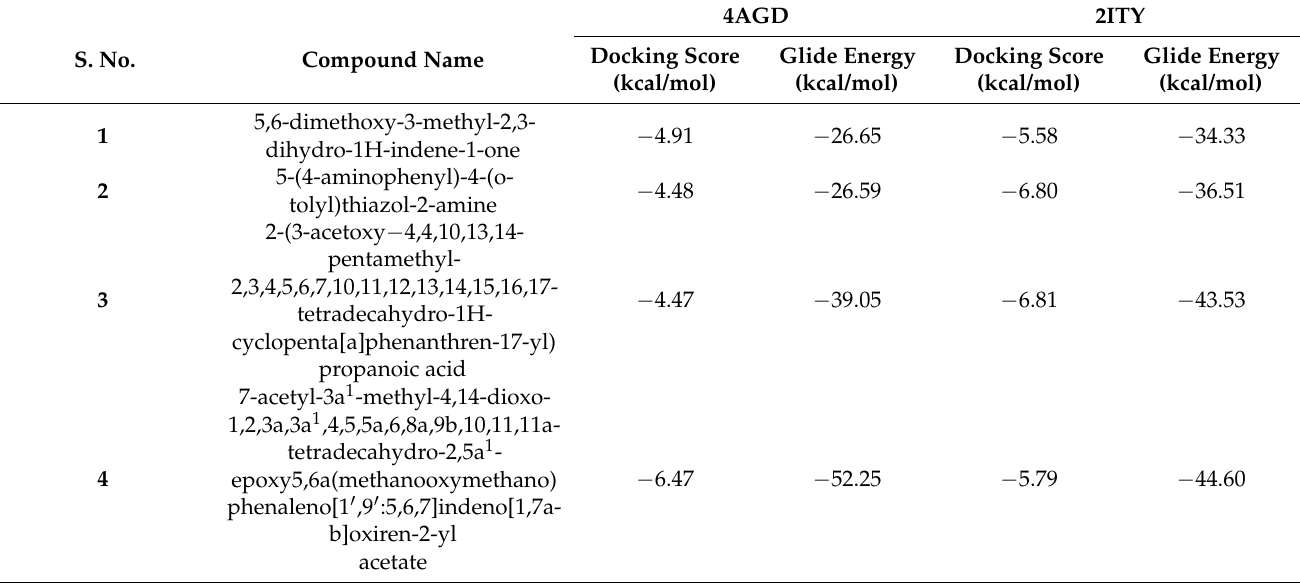
Table 5. Docking analysis of predicted compounds from the methanol extract of Azima tetracantha leaf with 4AGD/ 2ITY